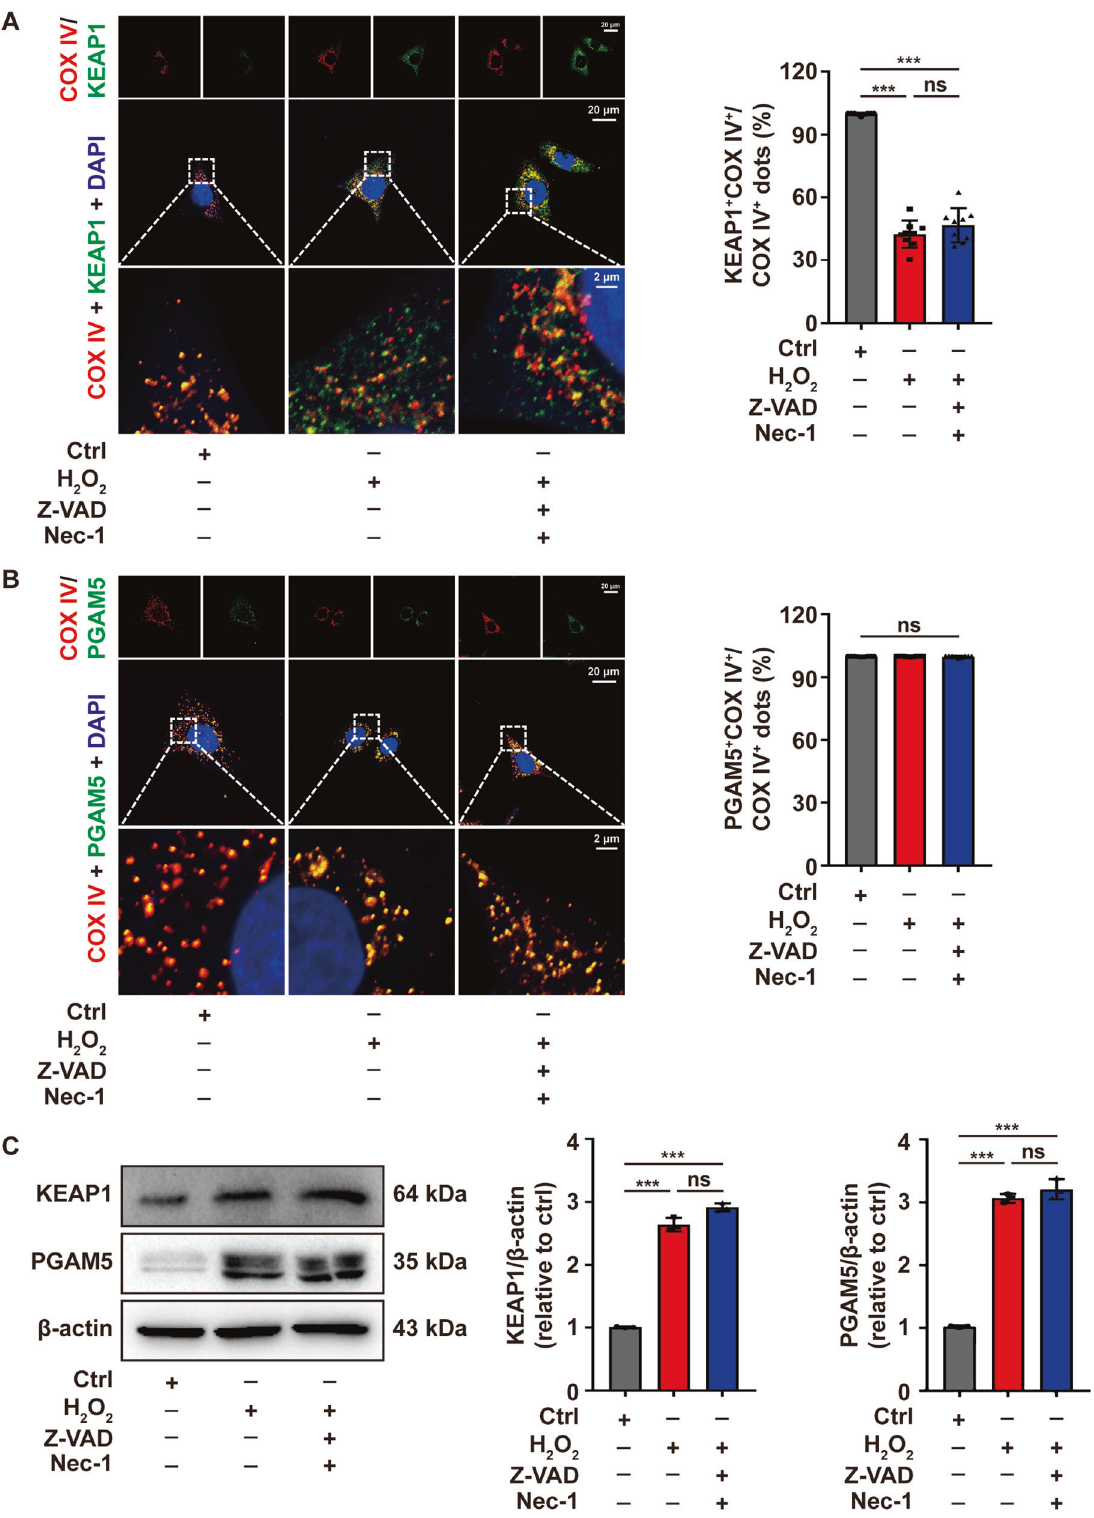
Fig. 3 The expression of KEAP1 and PGAM5 were upregulated in melanocytes under oxidative stress. The location of KEAP1 ( A ) and PGAM5 ( B ) in PIG1 cells stimulated by H 2 O 2 or pretreated with Z-VAD and Nec-1 prior to H 2 O 2 disposition, detected by immuno fl uorescence assay. C The expression of KEAP1 and PGAM5 in PIG1 cells treated with H 2 O 2 or pretreated with Z-VAD and Nec-1 prior to H 2 O 2 disposition, detected by Western-blot assay. *** P < 0.001, ns: not signi fi cant.